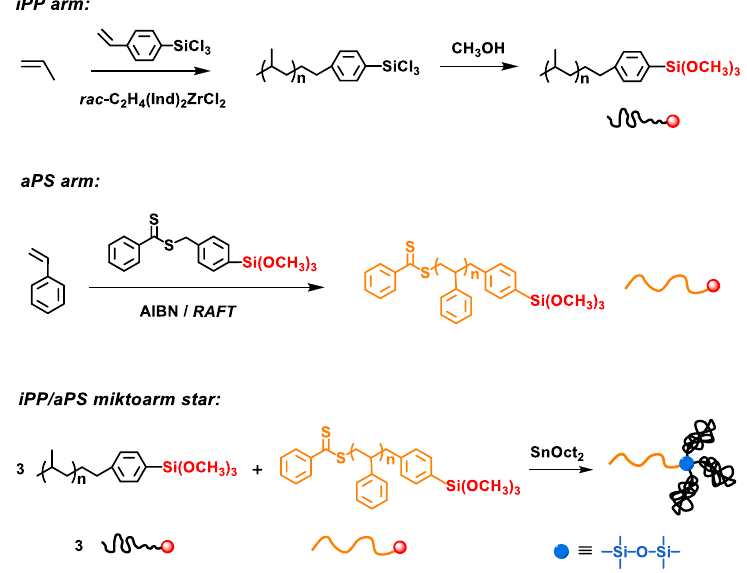
Chart 2. Reaction mechanism of intermolecular elimination catalyzed by SnOct 2